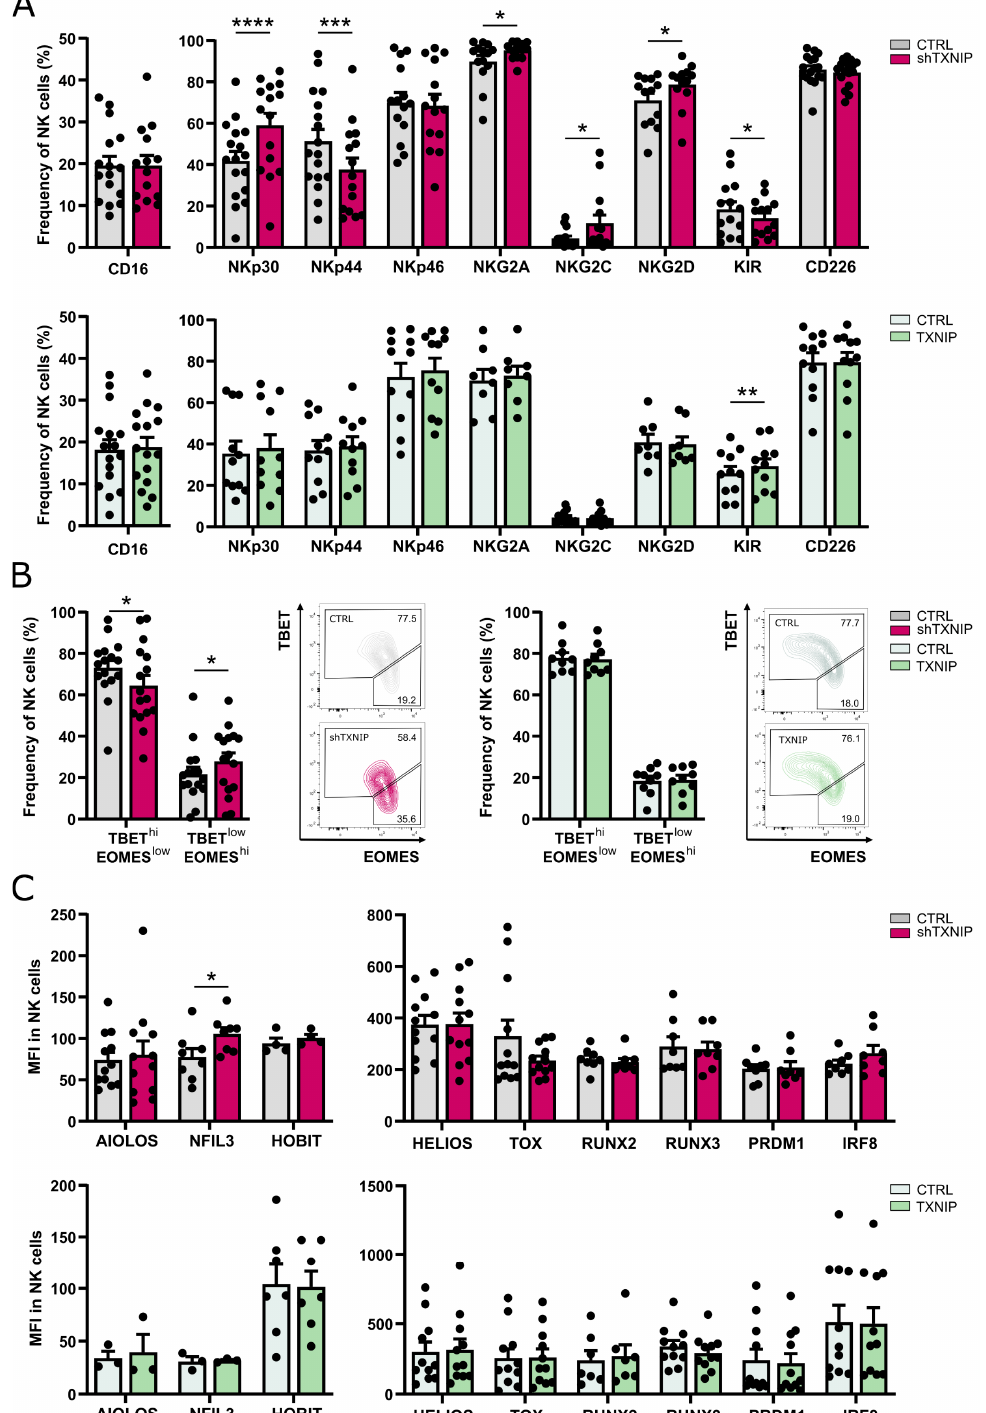
Figure 5. Partially altered phenotype of NK cells upon TXNIP knockdown. ( A ) On day 21 of culture, NK cells (eGFP + CD45 + CD11a + CD56 + CD94 + ) of TXNIP knockdown (top) or overexpression (bottom) conditions were analyzed for expression of the indicated cell membrane NK cell markers by flow cytometry. The frequency of expression is shown (mean ± SEM; n = 8–17). ( B ) Percentage of NK cells with a TBET hi EOMES low or TBET low EOMES hi phenotype on day 21 of TXNIP knockdown (left) and overexpression (right) cultures (mean ± SEM; n = 9–16). Representative dot plots are shown. ( C ) The